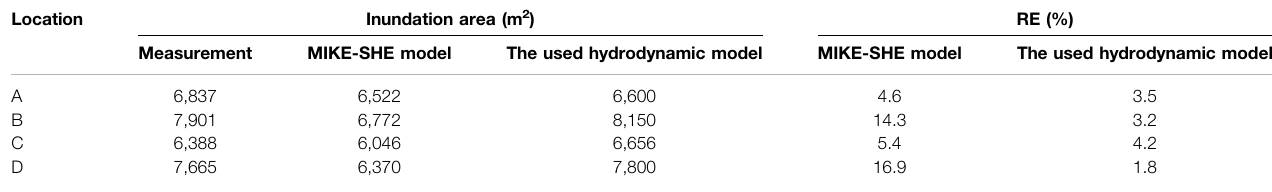
TABLE 6 | The error comparison of the used model and MIKE-SHE model (t (cid:2) 4